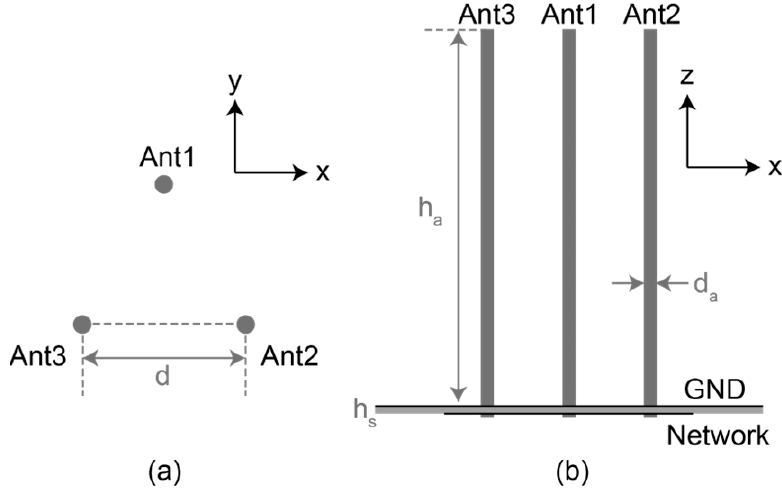
Figure 5. ( a ) Top view and ( b ) front view of the coupled three-element array.